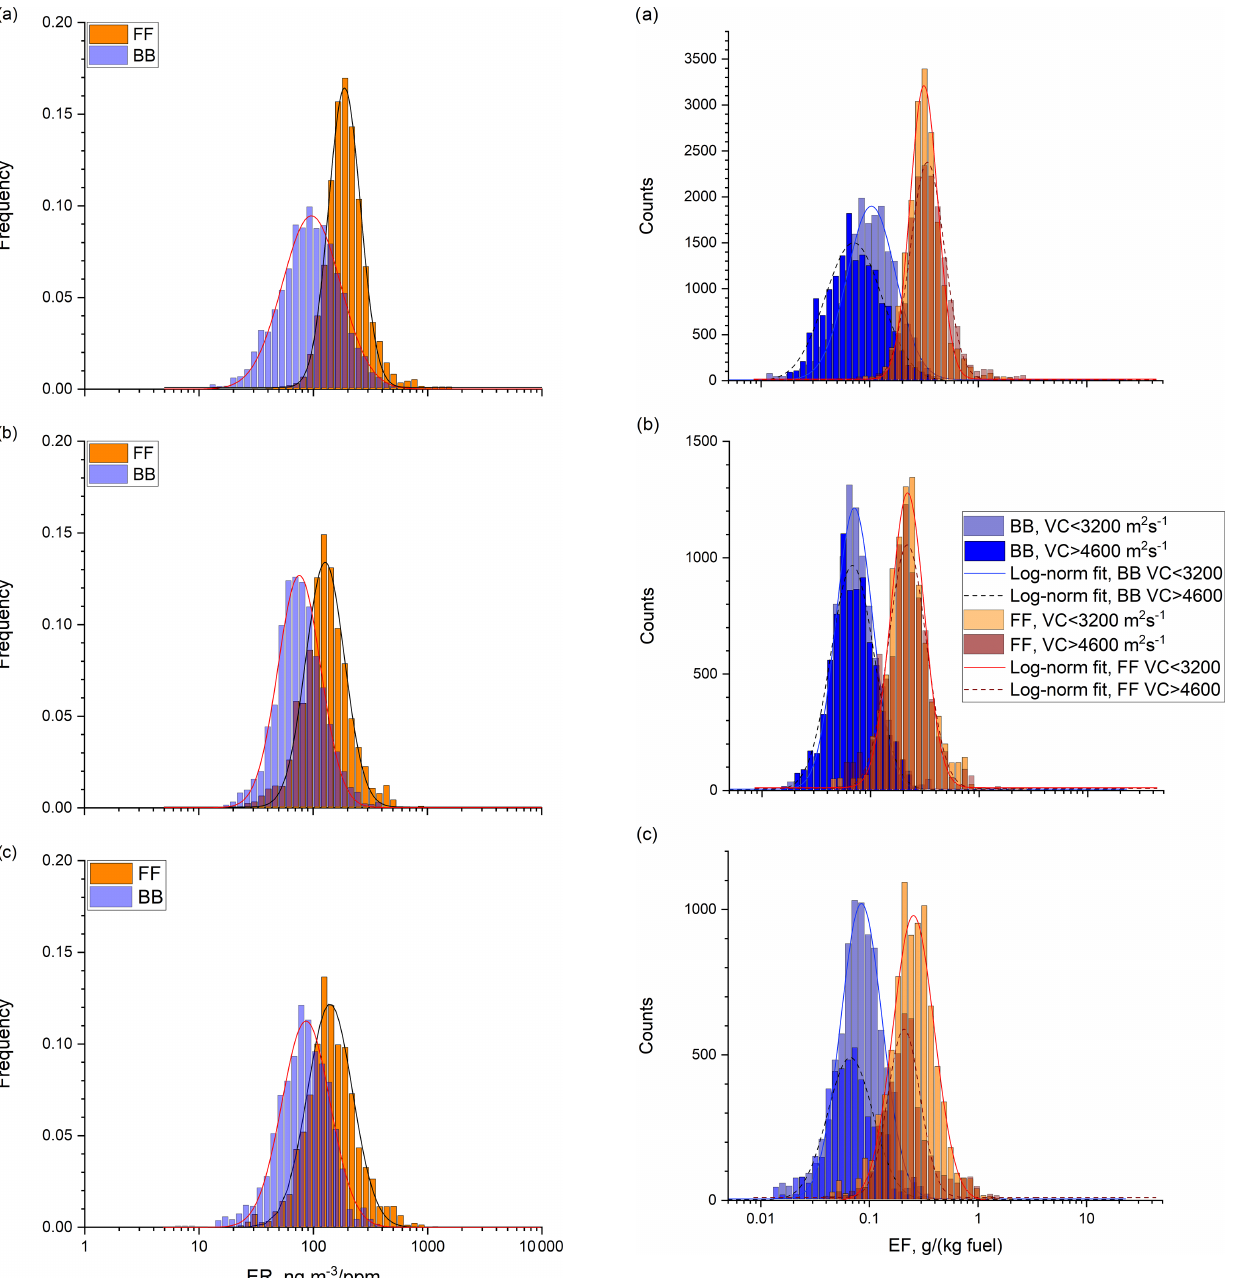
defined conditions for traffic EF measurements with concen- trated pollution that mostly originates from vehicle emission.